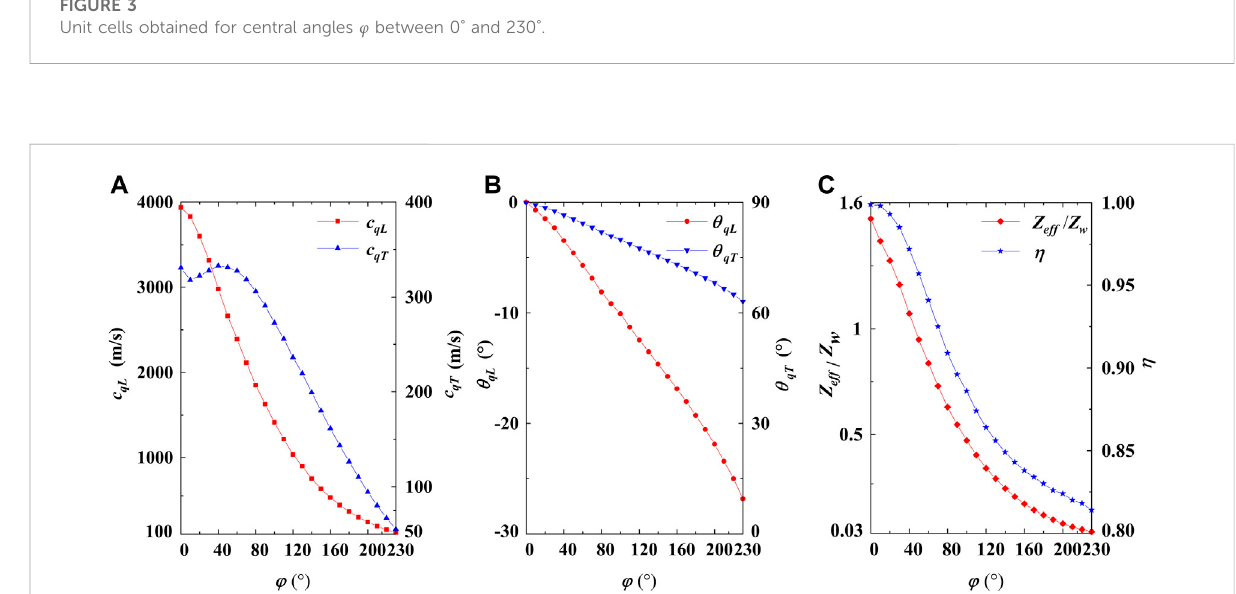
FIGURE 4 (A) The variation in phase velocities of the qL wave ( c qL ) and the qT wave ( c qT ) of the metascreens with central angle φ . (B) The variation in polarizationangles θ qL and θ qT ofthemetascreenswithcentralangle φ . (C) Thevariationinnormalizedimpedance Z eff / Z w andpolarizationfactor η of the metascreens with central angle φ